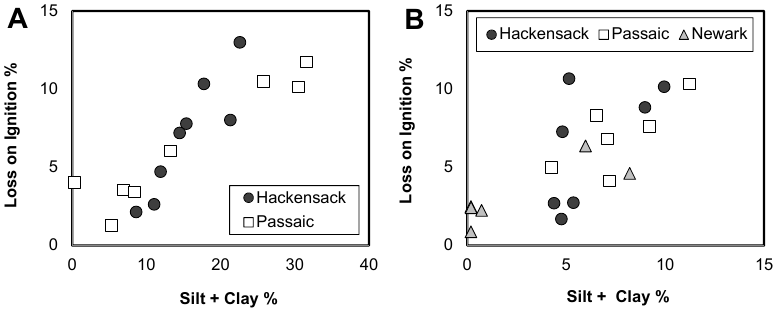
Figure 4. Correlation between sediment organic matter content (Loss on Ignition %) and the proportion of silt and clay fractions for sediments collected from the Hackensack River, the Passaic River, and the Newark Bay in summer: 2015 ( A ); and 2016 ( B ).